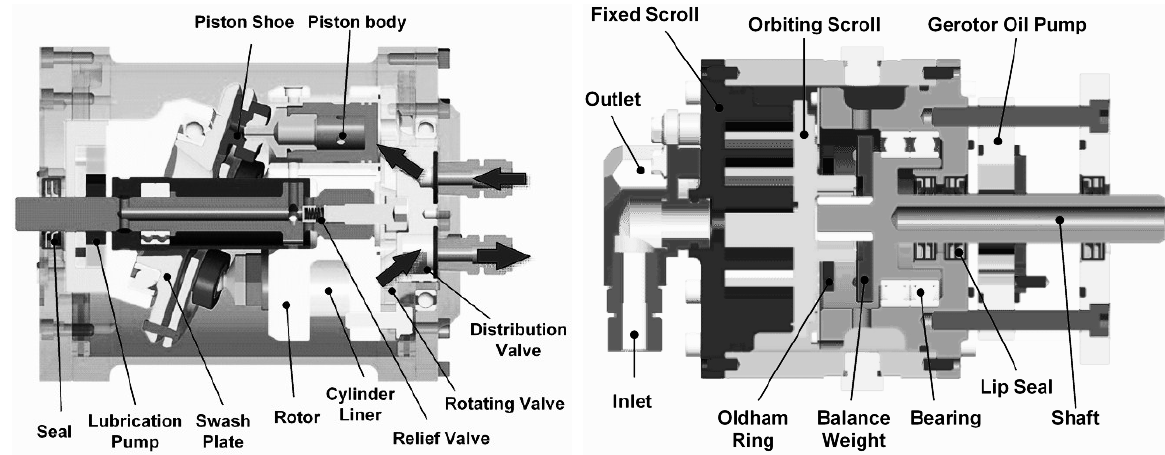
Figure 3. Swash plate-type expander for the HT cycle and scroll expander for the LT